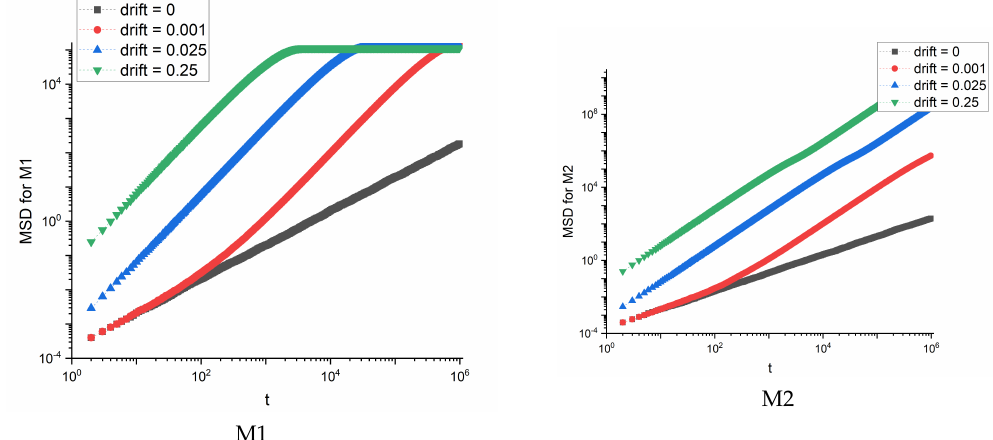
Figure 7. MSD dependence on time for artificial membranes M1 and M2.